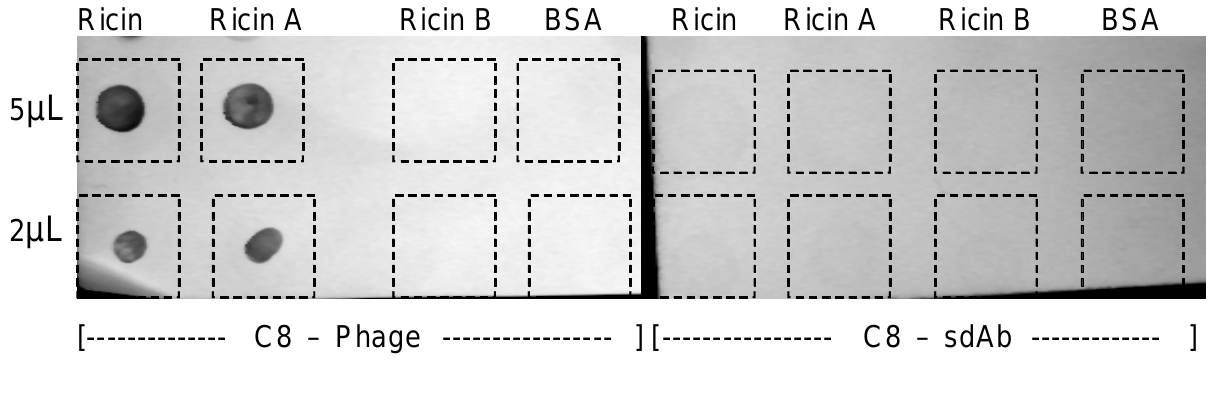
Figure 6 . Dot blot assay for ricin, ricin A chain, and ricin B chain using C8-phage (left) and C8-sdAb (right). C8-phage binding was visualized using HRP labeled anti M13 IgG while the C8-sdAb was visualized using HRP labeled anti-His. Color formation was generated using sigmafast Diaminobenzidine (DAB). 5 or 2 μ L of ricin, ricinA, ricin B or BSA (10 μ g/ mL) were spotted onto nitrocellulose as the target for both phage-displayed and soluble